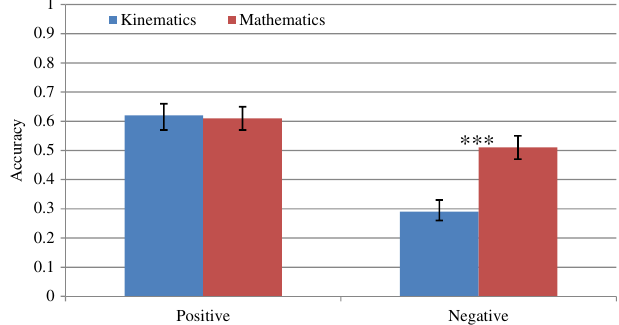
FIG. 4. GEE results for the term context * slope sign . The p value of the comparisons is indicated by * for p < 0 . 05 , ** for p < 0 . 01 , *** for p < 0 . 001 . A highly significant difference is found between the contexts for negative slopes.